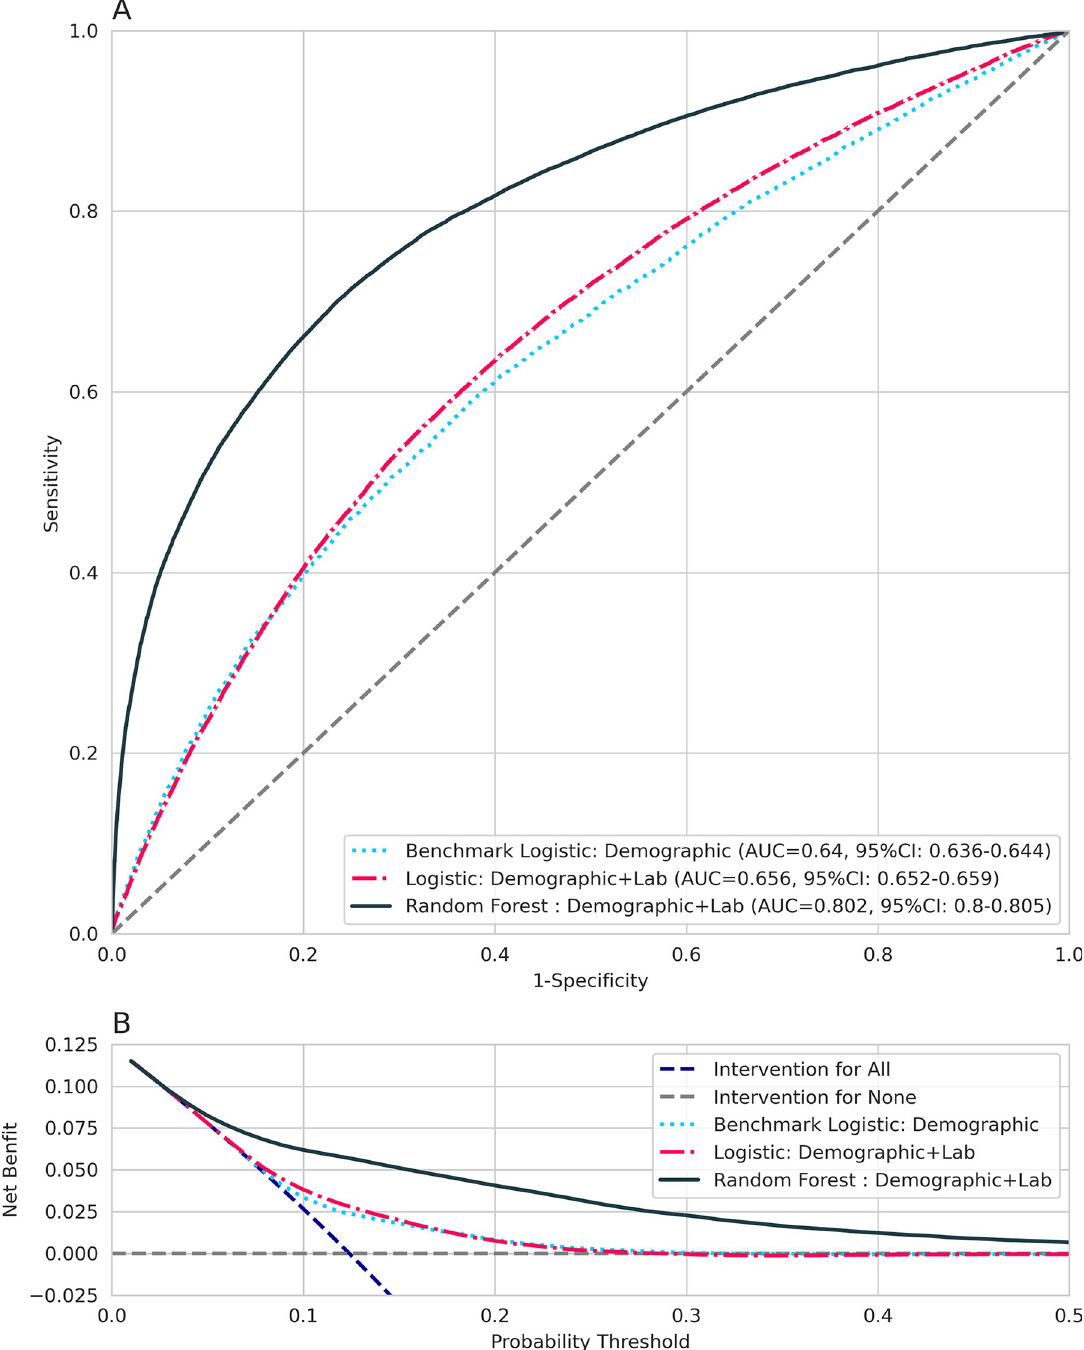
Fig 2. A) AuROC and B) DCA for prediction of flare in the next 6 months for the logistic regression model using demographic data, logistic regression using demographic and laboratory data, and random forest model using demographic and laboratory data. AUC = area under the curve; auROC = area under the receiver operating curve; DCA = decision curve analysis; RF = random forest model; ROC = receiver operating curve.